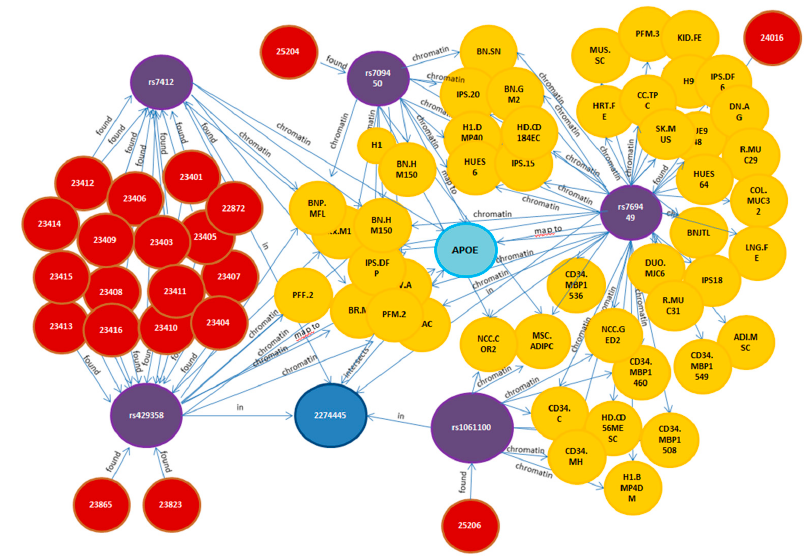
Figure 1. Head diffusion graph surrounding Apolipoprotein E (APOE). A graph representing Single Nucleotide Polymorphisms (SNPs) (purple circles), epigenetic information (chromatin states of genes), Linkage Disequilibrium (LD) blocks (blue circle), studies (orange circles) and cell types (yellow circles) displays relevant information associated with the APOE gene and its biology.